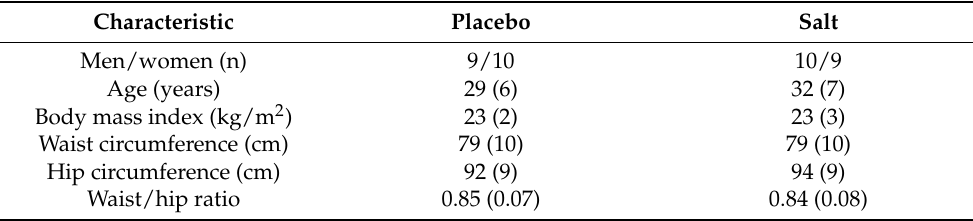
Table 1. Baseline characteristics of 38 healthy volunteers before the intervention 1 . Characteristic